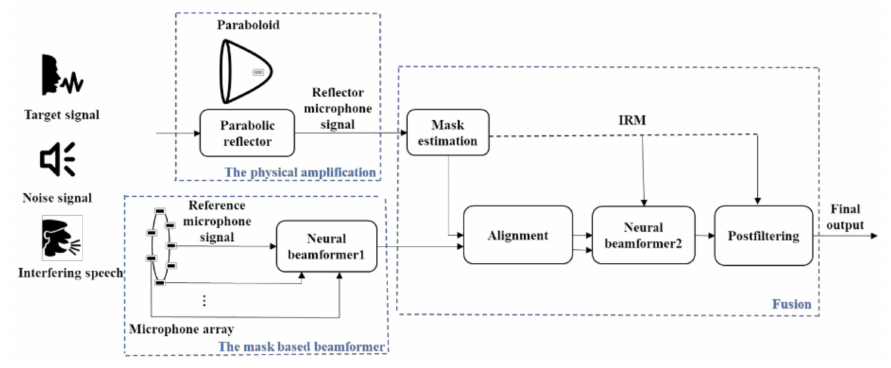
Figure 4. The overall diagram of our proposed